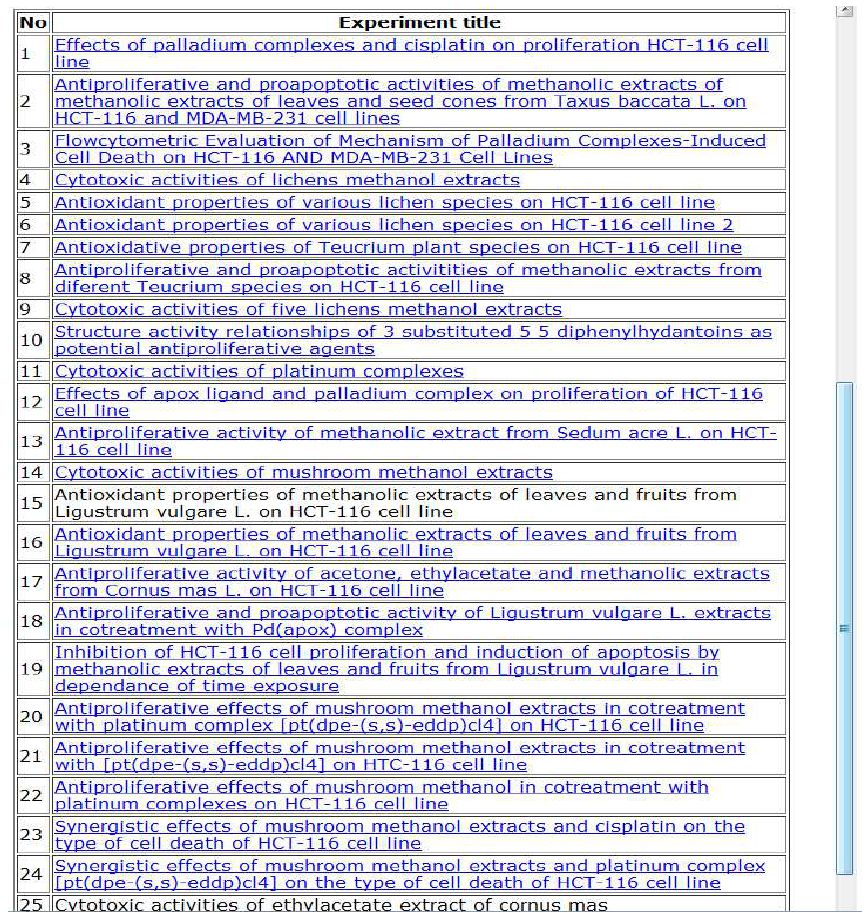
Figure 8. Unfiltered lists of experiments.